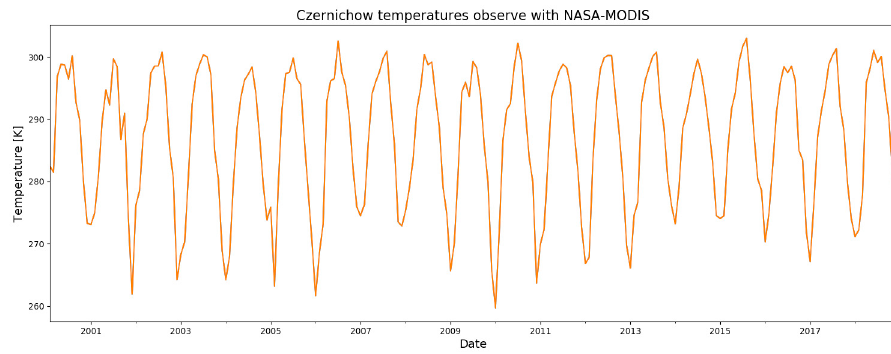
Figure 8. Original data series. Temperature (given in Kelvin) observed in 2000–2018 period by NASA–MODIS in Czernichow (Poland).